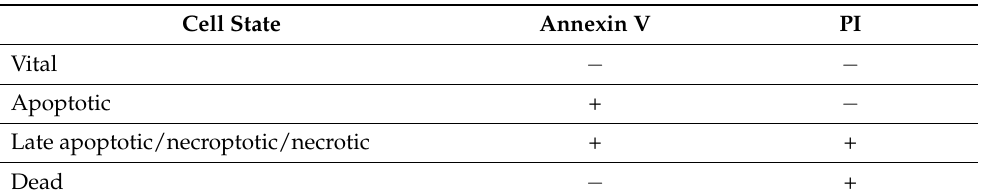
Table 5. Characteristics of fluorescence signals for apoptosis classification of PMNs using flow cytometry.